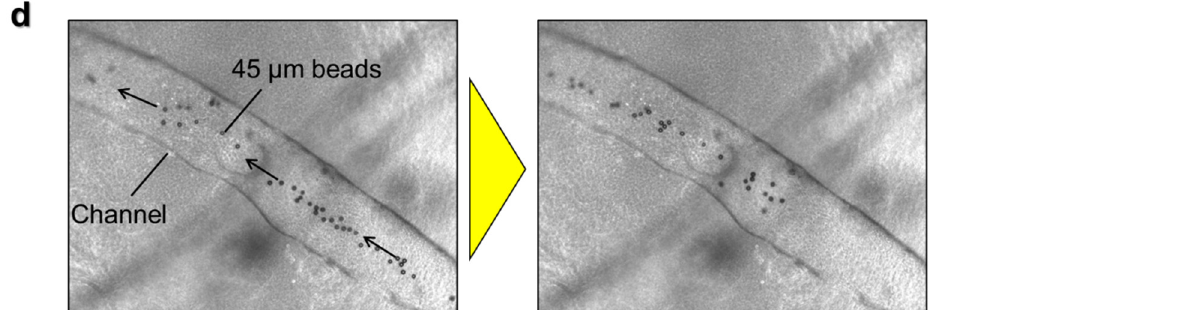
Figure 5. ( a ) Projection images of z -stack imaging from bottom half and top half with 4× magnification lens and enlarged view with 10× magnification lens. Green fluorescence shows actin filament of the HUVECs. ( b ) Projection image after superposition of the images from top and bottom. ( c ) Projection image after z -stack scanning from inlet by rotating the cube device at 90 °. ( d ) Microbeads of 45 µm flowing through the lumen of the channels seeded with HUVECs.